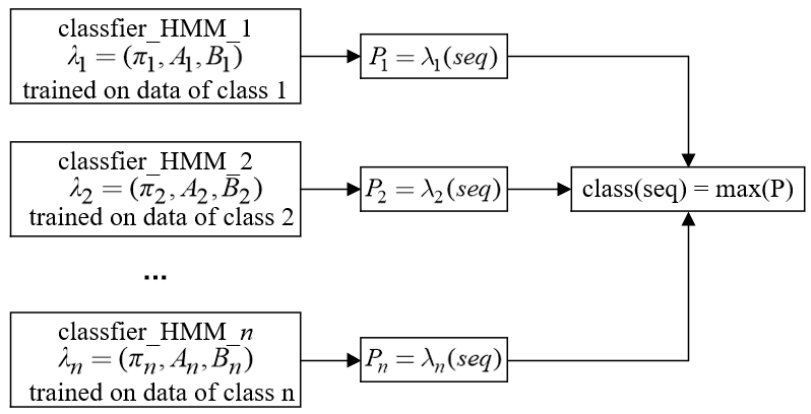
Figure 2. HMM classifier structure